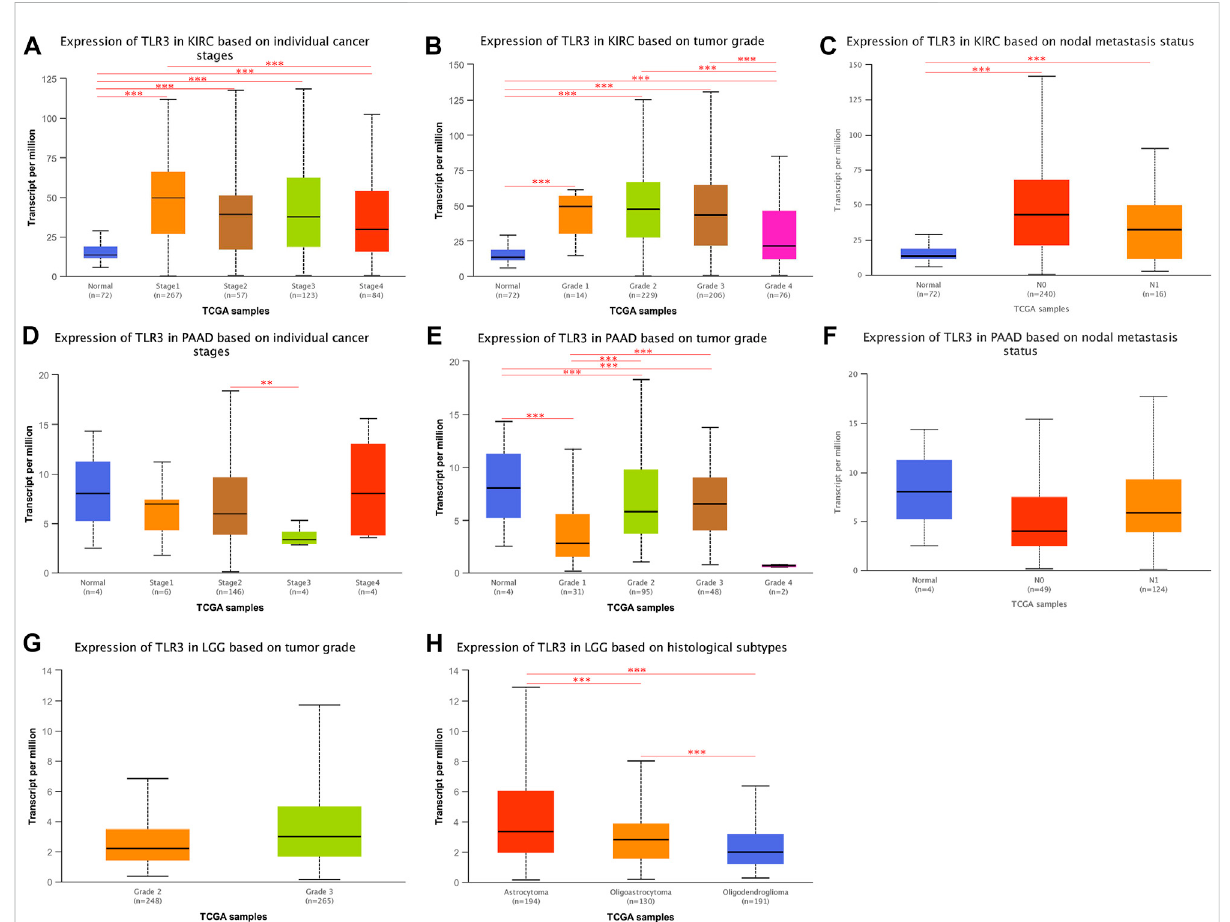
FIGURE 4 The expression of TLR3 transcript at different phases of KIRC, PAAD and LGG. (A – C) Box plots showing the expression of TLR3 transcript based on cancer stages, tumor grades and lymph nodal metastasis status of KIRC, respectively. (D – F) Box plots showing the expression of TLR3 transcript based on cancer stages, tumor grades and lymph nodal metastasis status of PAAD, respectively. (G) Box plot showing the expression of TLR3 transcript based on tumor grades of LGG. (H) Box plot showing the expression of TLR3 transcript based on histological subtypes of LGG. * p < 0.05; ** p < 0.01; *** p <